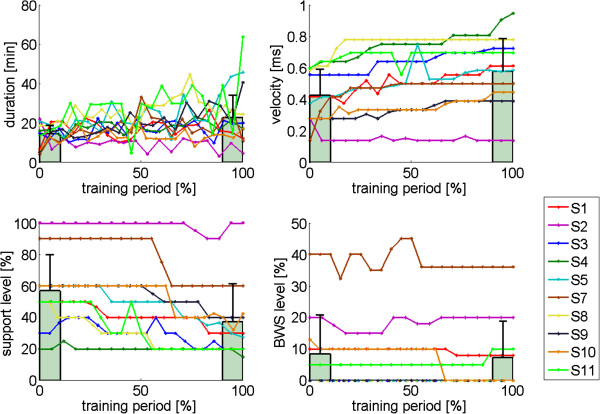
Training parameters as a function of the training duration. Training sessions are normalized to the total training time (0 percent start of training, 100 percent completion of training). Training duration refers to the actual total training time per session (excluding setup time and rest periods). Support levels are expressed as a percentage of the maximum stiffness that could be controlled by the LOPES (300 Nm/rad). BWS was only required in five of the 10 participants. The bars indicate the mean training parameters, averaged across participants, at the start of the training (0-10 percent) and at the end of the training period (90-100 percent). The error bars indicate the standard deviation.